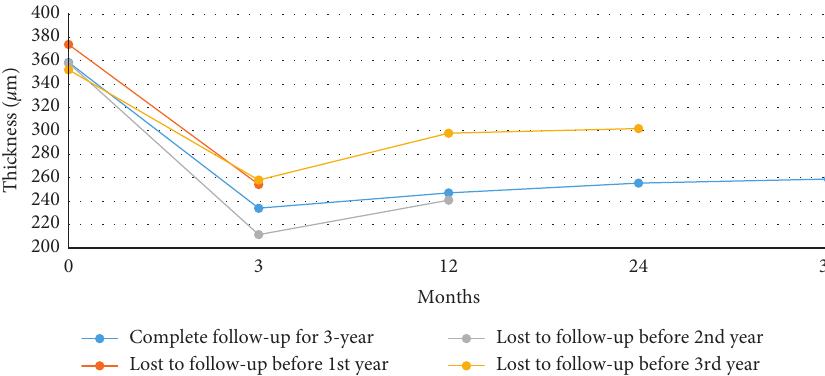
Figure 2: Central macula thickness at month 3, year 1, year 2, and year 3 in lost to follow-up before year 1, year 2, and year 3 and complete 3- year follow-up groups.